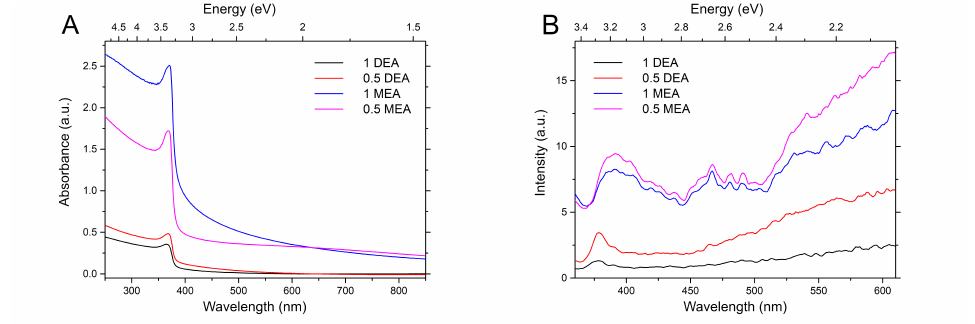
Figure 13. Absorbance ( A ) and photoluminescence ( B ) of samples grown on